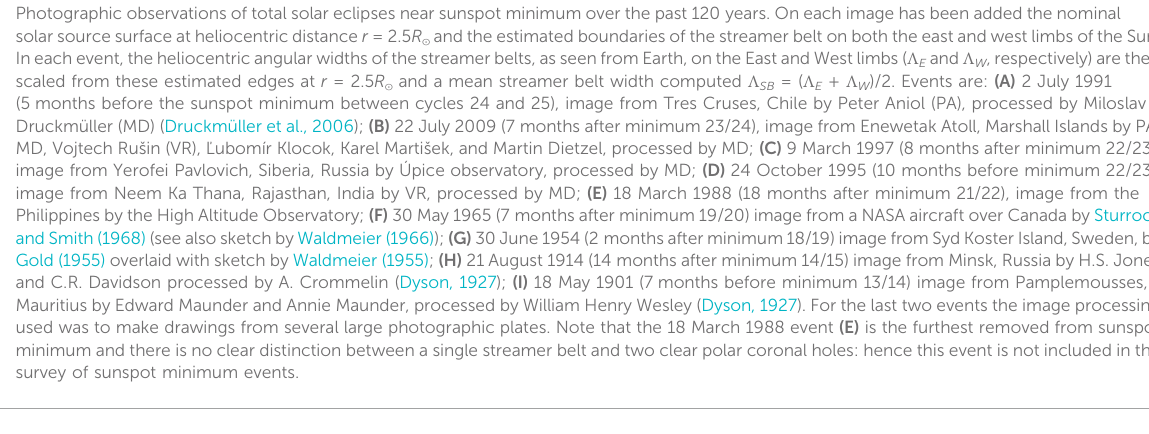
Figure 1 shows a series of images of eclipses taken near sunspot minimum over the past 120 years. The image E for the 18 March 1988 event is a long time (18 months) from the minimum between cycles 21 and 22 and, unlike the others shown, does not have a clear, de fi nitive single streamer belt separated by clear polar coronal holes: it is an example of an image that is not included further in this study because it is too removed from sunspot minimum. The other images in Figure 1 demonstrate that the streamer belt around sunspot minimum is not constant in width. An estimate of the width of the streamer belt can be made by taking the difference, in heliographic latitude, of the edges of the streamer belt at a set value of r (we here use the nominal coronal “ source surface ” at r = 2.5 R ⊙ ).